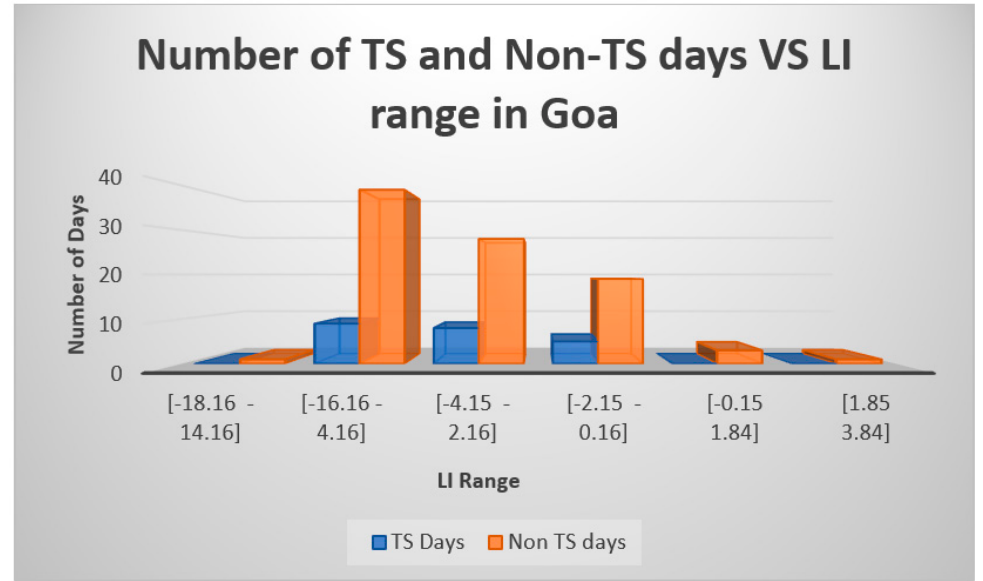
Figure 4. The distribution of thunderstorm and non-thunderstorm days in the given SI range over Goa. As can be seen here, Thunderstorms are more prominent between the LI range of − 16.6 and − 4.16 °C.